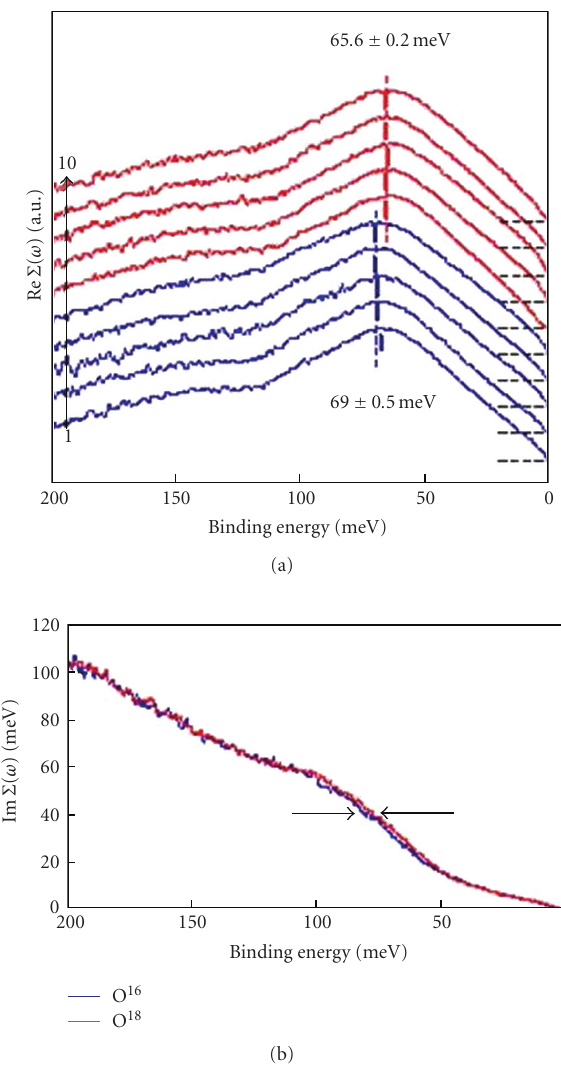
Figure 34: (a) E ff ective Re Σ for five samples for O 16 (blue) and O 18 (red) along the nodal direction. (b) E ff ective Im Σ determined from MDC full widths. An impurity term is subtracted at ω = 0. From